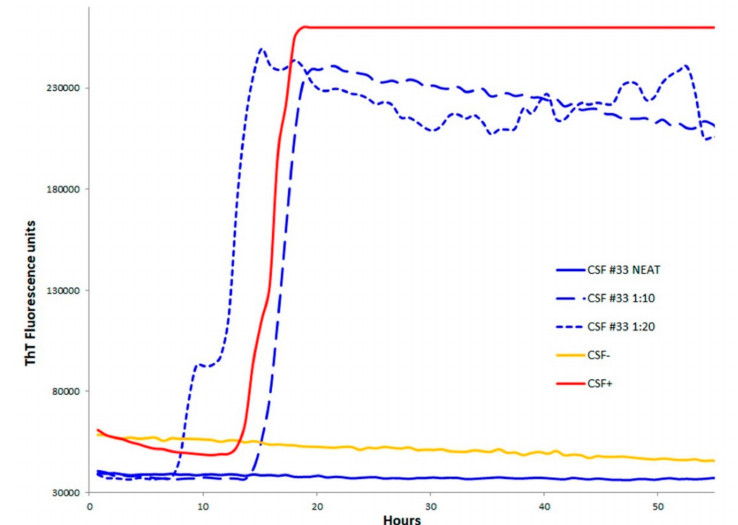
Figure 1. Patient #33 RT-QuIC analysis of neat and diluted (1:10 and 1:20). The analysis is also representative of CSF sample